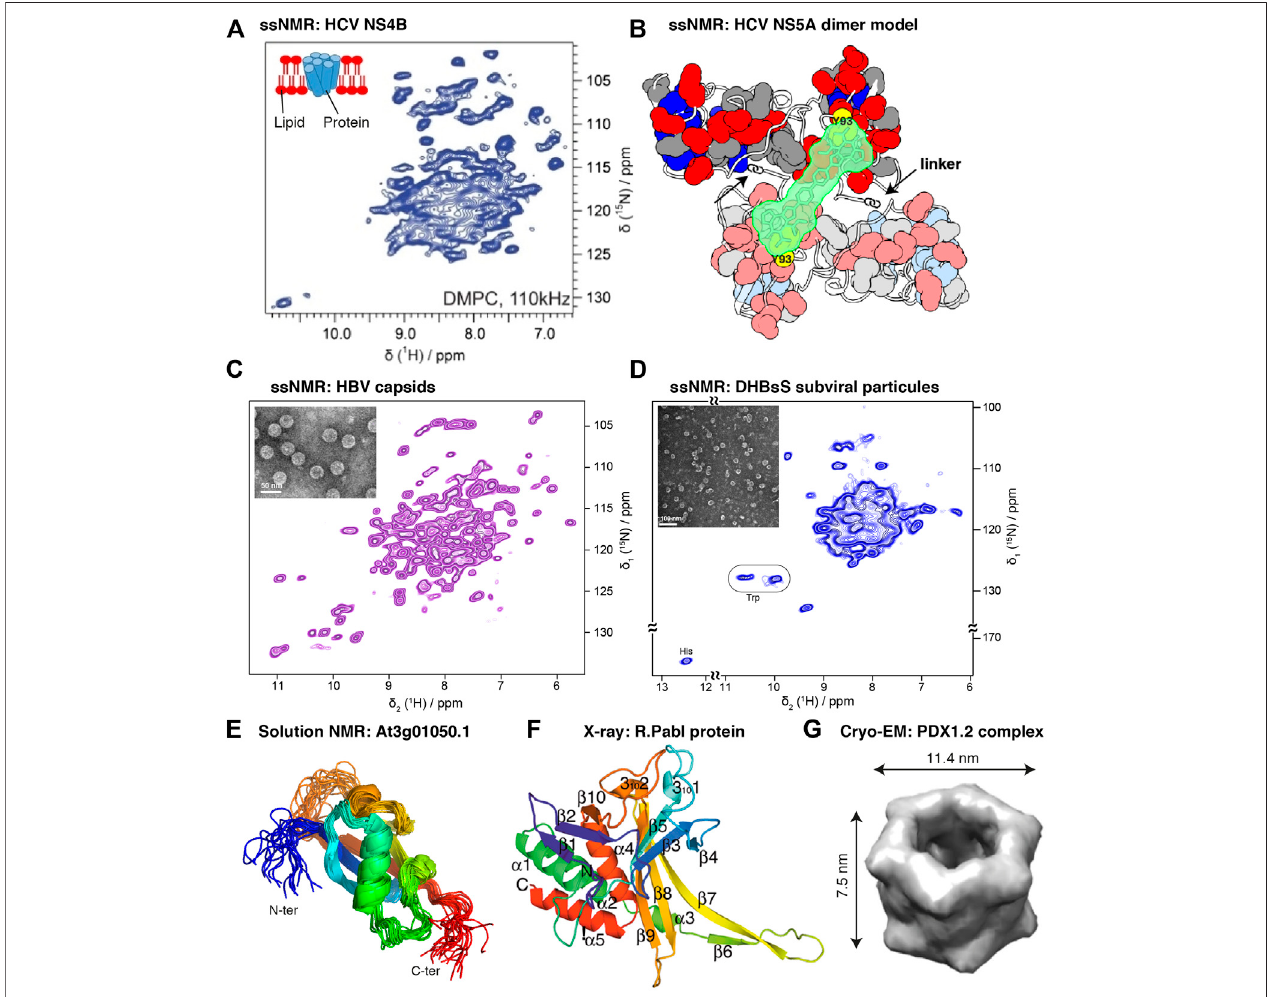
FIGURE 7 | Examples of structural studies on proteins expressed in WGS using NMR, X-ray crystallography, and cryo-EM. (A) Solid-state NMR spectrum of the HCV membrane protein NS4B reconstituted into DMPC lipids (Jirasko et al., 2020). (B) Dimer orientation in lipids of the HCV helix anchor and domain 1 (AHD1) of the NS5A protein as determined by solid-state NMR (Jirasko et al., 2020). (C) Solid-state NMR spectra of the hepatitis B virus capsid (Wang et al., 2019) and of (D) the subviral particles made of duck HBV small envelope protein (DHBs S) (David et al., 2018). The three spectra have been recorded at 110 kHz MAS on an 850 MHz spectrometer. Both HBV capsids and subviral particles were autoassembled during cell-free synthesis; their negative-staining electron microscopy images are shown insidethecorrespondingspectrum. (E) 20conformers obtainedbysolutionNMRofAt3g01050.1protein (Vinarovetal.,2004)(PDB1se9, fi gure prepared usingPyMoL (https://pymol.org/2/). (F) StructureofrestrictionendonucleasePabIobtainedbyX-raycrystallography(Miyazonoetal.,2007;Watanabeetal.,2010)(PDB2dvy). (G) 3D cryo-EM reconstruction of PDX1.2 complex at 15 Å resolution (Novikova et al., 2018). Figures were adapted with permission from Jirasko et al. (2020) for panel A, from Wang et al. (2019) for panel C, and from David et al. (2018) for panel D and reprinted with permission from Jirasko et al. (2020) for panel D, from Miyazono et al. (2007), Watanabe et al. (2010) for panel F, and from Novikova et al. (2018) for panel G .